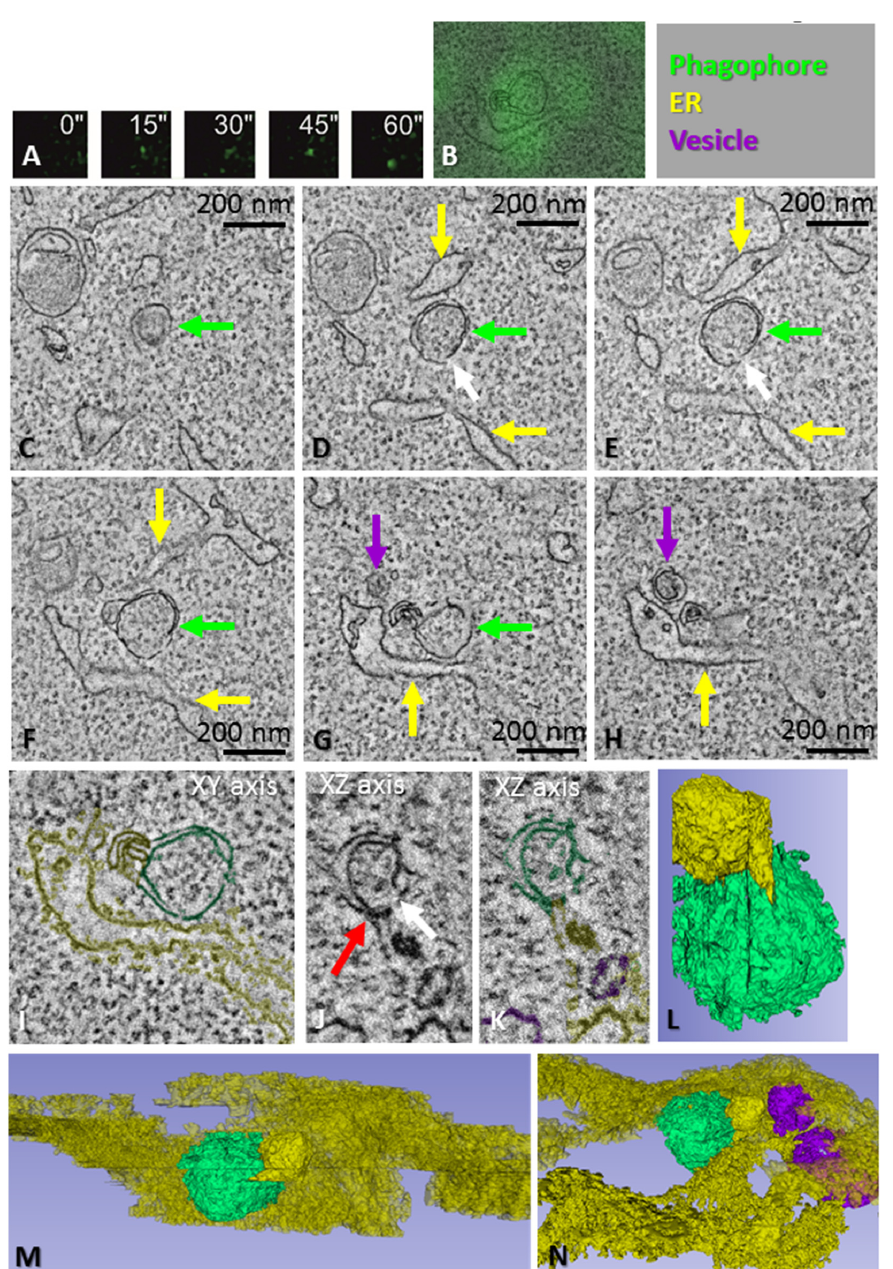
Figure 3. CLEM of a phagophore precursor. ( A ) HEK293 cells expressing GFP-tagged ATG13 were time-lapse imaged to trace ATG13 puncta. The cells were fixed 60 s after the appearance of the ATG13 punctum. After fixation, the same cell and punctum were imaged with electron tomography. ( B ) One slice of the tomogram overlaid with the ATG13 fluorescence. ( C – H ) Tomography slices showing the phagophore precursor (green arrows), ER (yellow arrows) and cup-shaped vesicles (purple arrows). The white arrows in panels ( D , E , J ) indicate a small opening in the phagophore precursor. Note the phagophore precursor contains ribosomes, similar to the cytoplasm around it. ( I ) Organelles in the tomogram were traced with different colors, as indicated by the overlay, as well as the top right panel of the figure. ( J , K ) Tomography slice showing the phagophore precursor and ER from a different angle compared with panels ( B – I ). Note the MCS between the phagophore precursor and ER (red arrow in panel ( J )), and the small opening in the phagophore precursor (white arrow in panel ( J )). ( L – N ) Views of the 3D model from different angles, demonstrating the close apposition of the phagophore precursor and ER, as well as the vesicles. See also Supplementary Figure